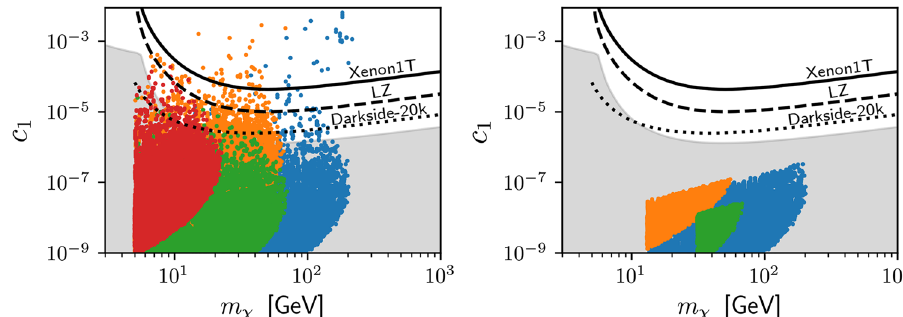
Fig. 7 Theoretical predictions for the anapole coupling, A , as a func- tionoftheDMmass, m χ forthefourbenchmarkpoints:A1(redpoints), A2 (green), B1 (orange), and B2 (blue). For comparison, we show the current exclusion line by Xenon1T [92] and the predicted reach of LZ Fig. 8 The same as in Fig. 7, but for the